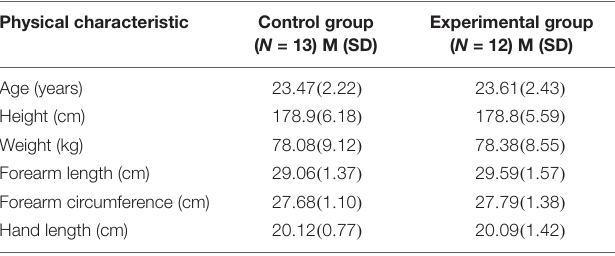
TABLE 1 | Means (M) and standard deviations (SD) for the physical characteristics of the participants by group. Physical